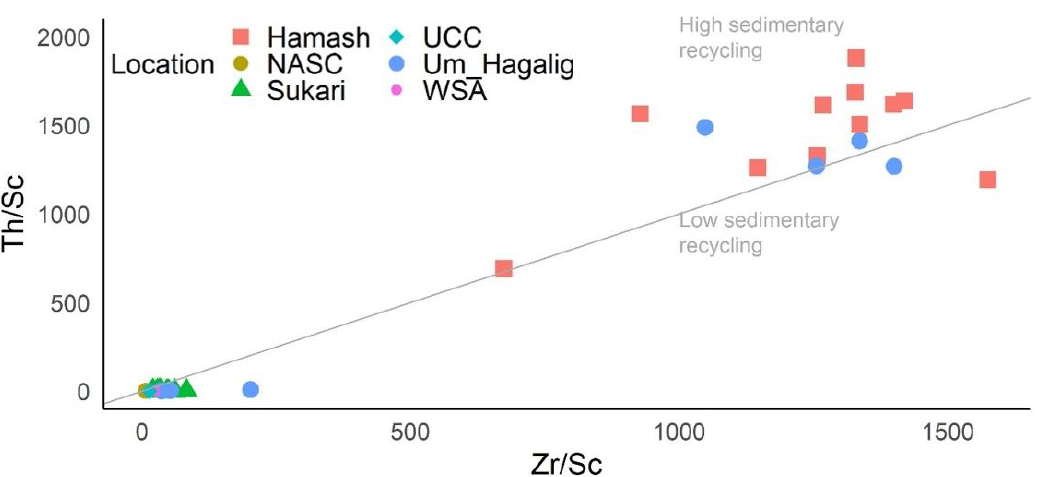
Figure 6. Th/Sc vs. Zr/Sc relationship showing Zr enrichment and proving high sediment recycling in Hamash. The corresponding values from the literature were provided. The values were reported by Rudnick and Gao [41] for upper continental crust UCC, Gromet, Haskin, Korotev, and Dymek [38] for North American shale composite NASC, Taylor, and McLennan [40] for Post Archean Australia Shale PAAS, and Kabata-Pendias [39] for world soil average WSA. Background after Bhatia and Crook [42].